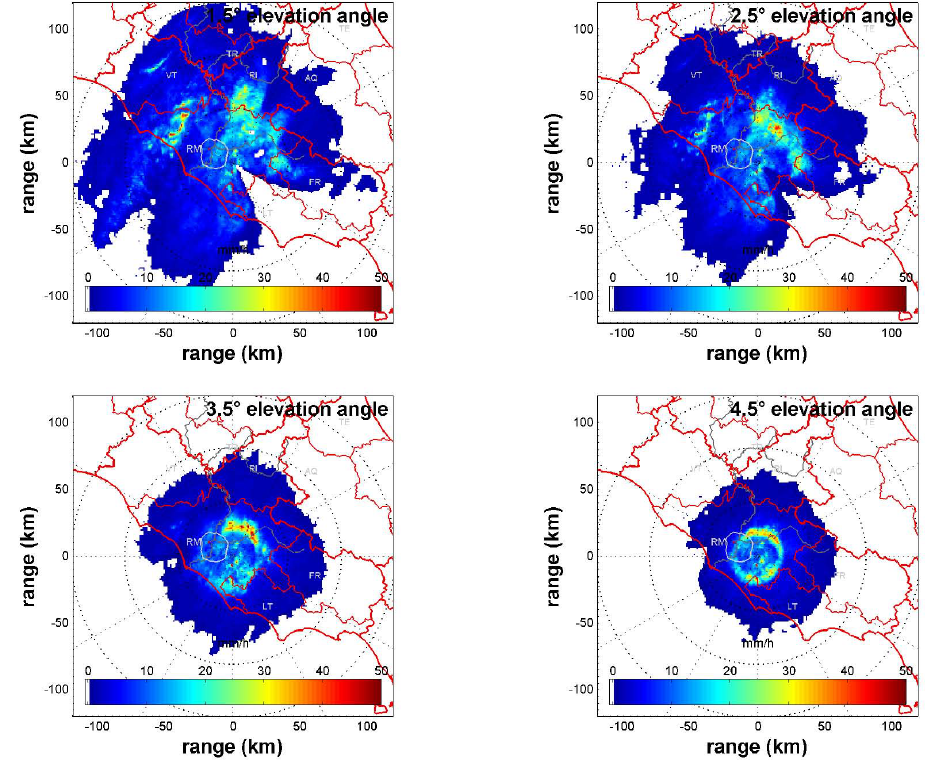
Fig. 10. Rain rate (mmh − 1 ) maps obtained from a volume scanning at 15:40 p.m. during the convective event of 5 December 2008.